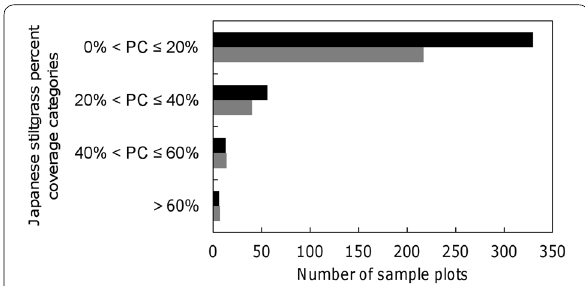
Fig. 2 Comparison of the percent coverage (PC) of Japanese stiltgrass during the first survey (2000–2005, gray bar) and the second survey (2006–2011, black bar) conducted by the Forest Inventory and Analysis Program of the U.S. Forest Service. Results are summarized in terms of the number of plots in each of the indicated categories: 0% < PC 20%, 20% < PC 40%, 40% < PC 60%, and PC > ≤ ≤ ≤